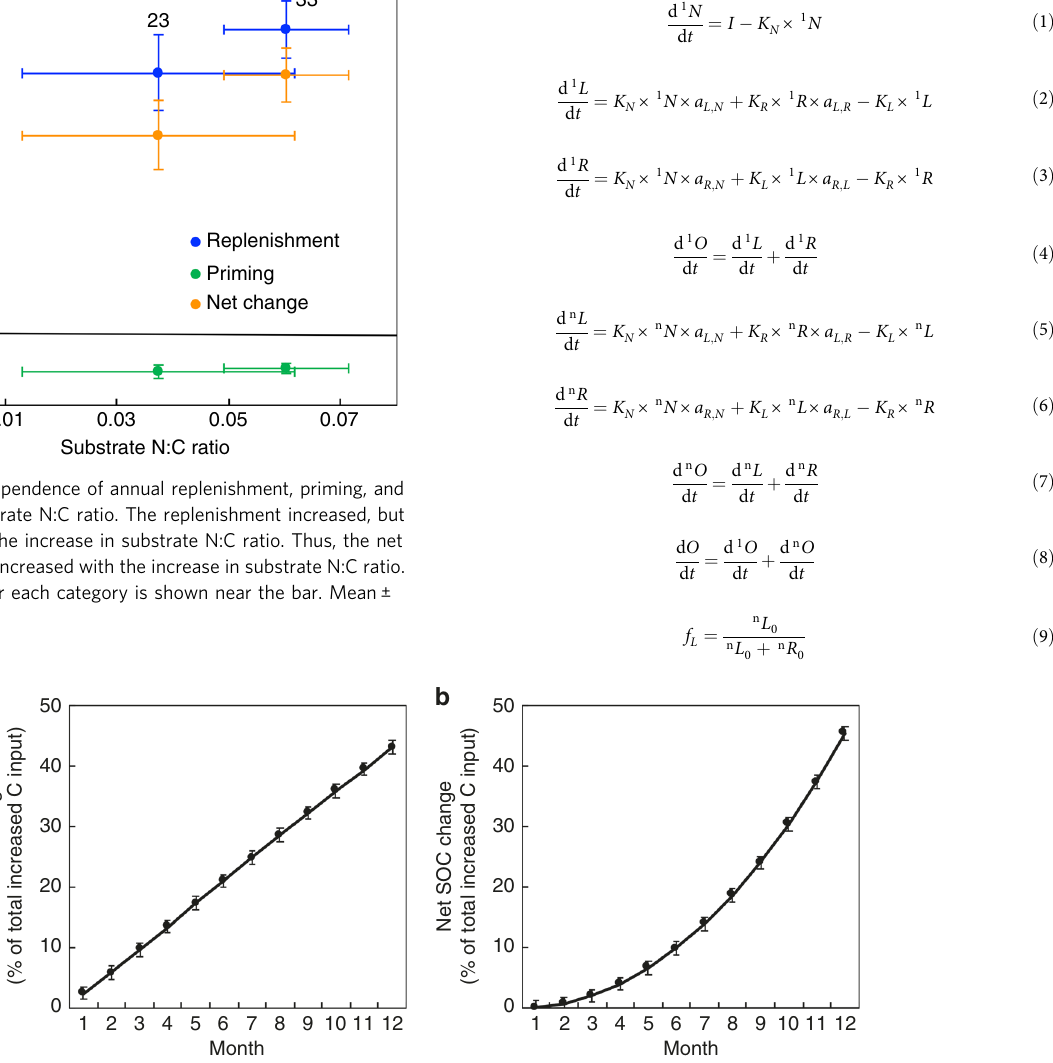
Fig. 6 Synthesis of the modeling experiment. The modeling experiment showing net SOC increase by continuously increased C inputs. a Predicted net SOC change by a 10% step increase in C input for 1 year. b Predicted net SOC change by gradual increase in C input. Mean± 95% con fi dence interval